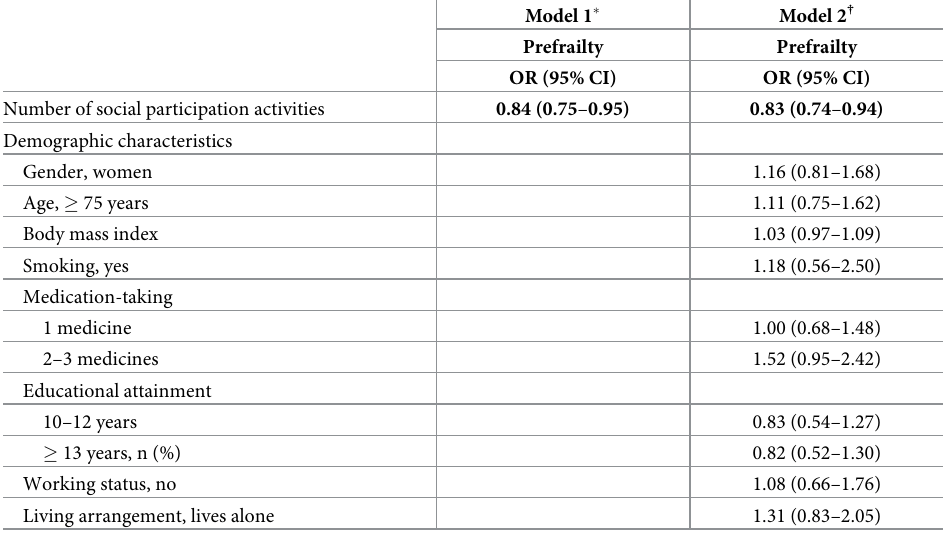
Table 2. Associations between number of social participation activities and prefrailty among Japanese older adults (n =